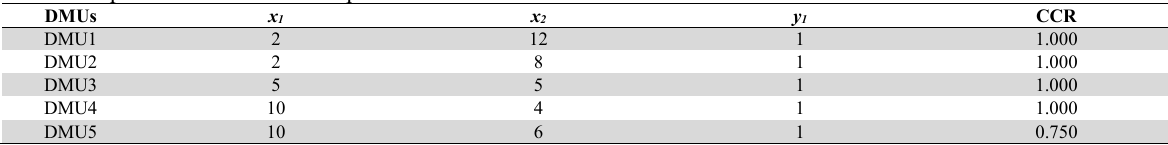
Data set of performance assessment problem